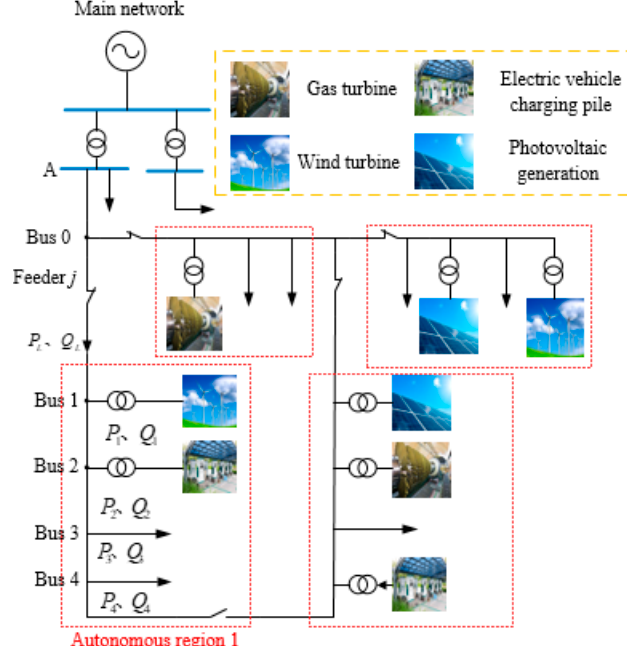
Figure 1. Schematic diagram of active distribution network (ADN).